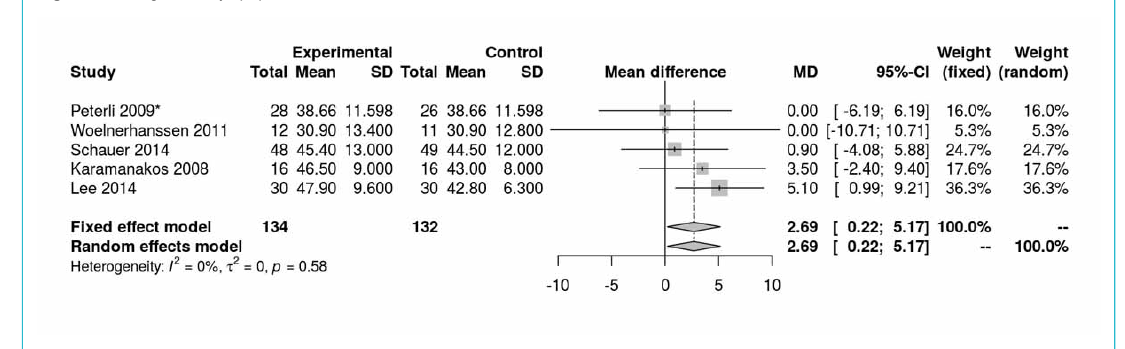
Figure S3a: High-density lipoprotein at